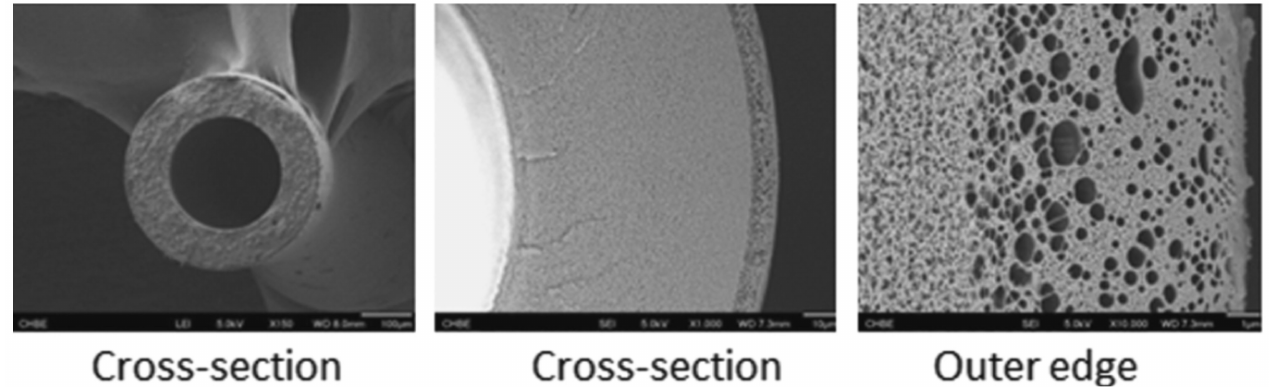
Figure 9. The morphology of a dual-layer HF membrane. Reprinted and adapted with permission from Ref. [73]. Copyright 2015,